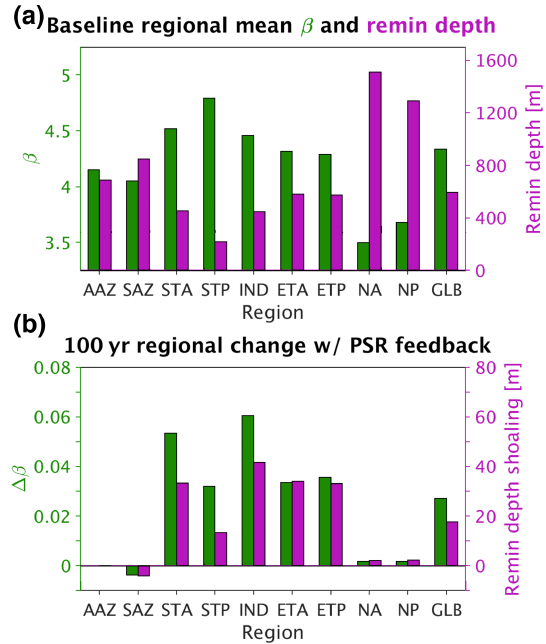
Figure 6. (a) Baseline (current-day circulation, ran to steady state) regional mean β (shown in green) and e -folding remineralization (remin) depth (shown in purple). (b) Absolute change in regional mean β (shown in green) and absolute shoaling of regional mean remineralization depth (shown in purple) 100 years after decreasing circulation rates by 10% with the PSR feedback turned on. GLB stands for global